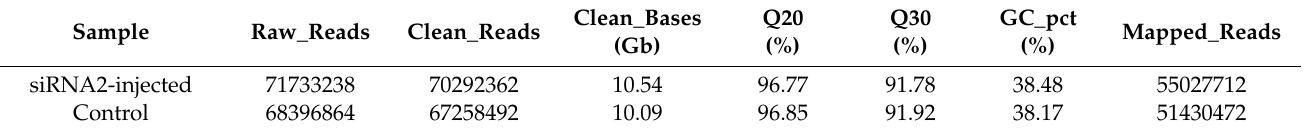
Table 1. Summary of sequencing reads after filtering.